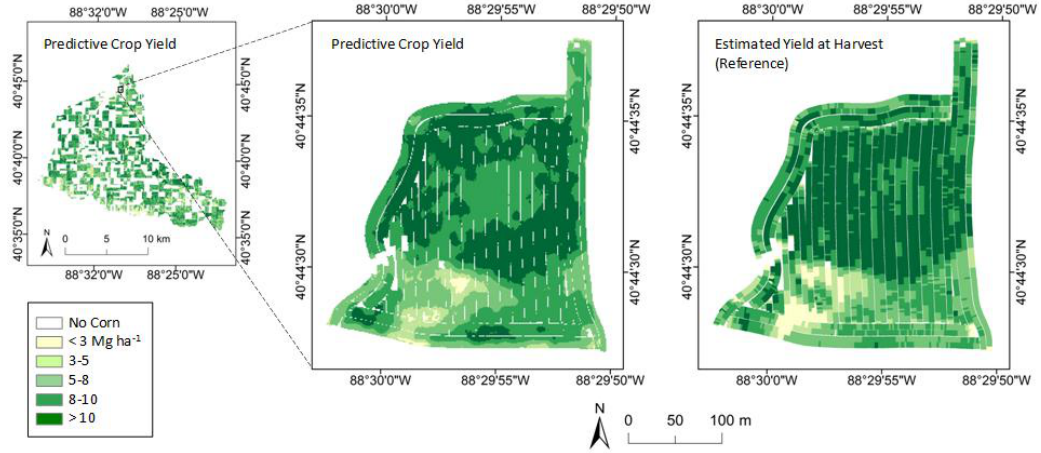
Figure 2. Predicted corn yield maps generated based on the regression model of the watershed ( left ) and the study field ( center ); and reference yield map at harvest ( right